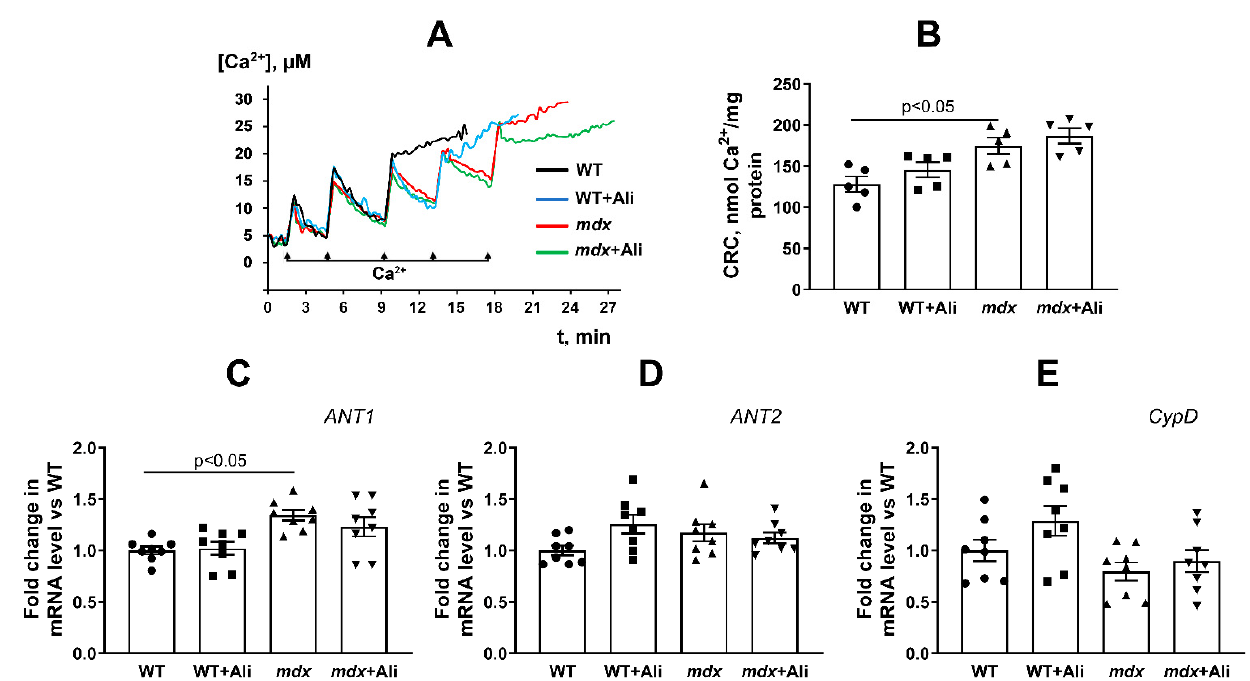
Figure 3. The opening of Ca 2+ -dependent MPT pore in the heart mitochondria of studied groups of mice. Uptake of sequential Ca 2+ additions by the heart mitochondria ( A ). Pulse additions of 10 µ M Ca 2+ are indicated by arrows. The figure shows traces of a typical experiment conducted at the same time on the same mitochondrial preparation. Similar results were obtained in 5 independent experiments. Ca 2+ retention capacity (CRC) of heart mitochondria of studied groups of mice ( B ). The data are presented as means ± SEM ( n = 5). Gene expression of MPT-related proteins measured by real-time PCR: ANT1 ( C ), ANT2 ( D ), CypD ( E ). The data are presented as means ± SEM ( n = 8).